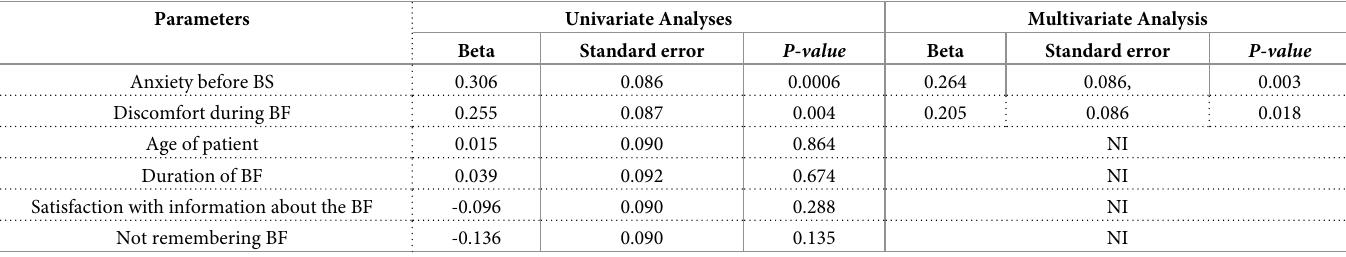
Table 3. Univariate and multivariate linear regression analysis of the variables associated with patient satisfaction with bronchoscopy.